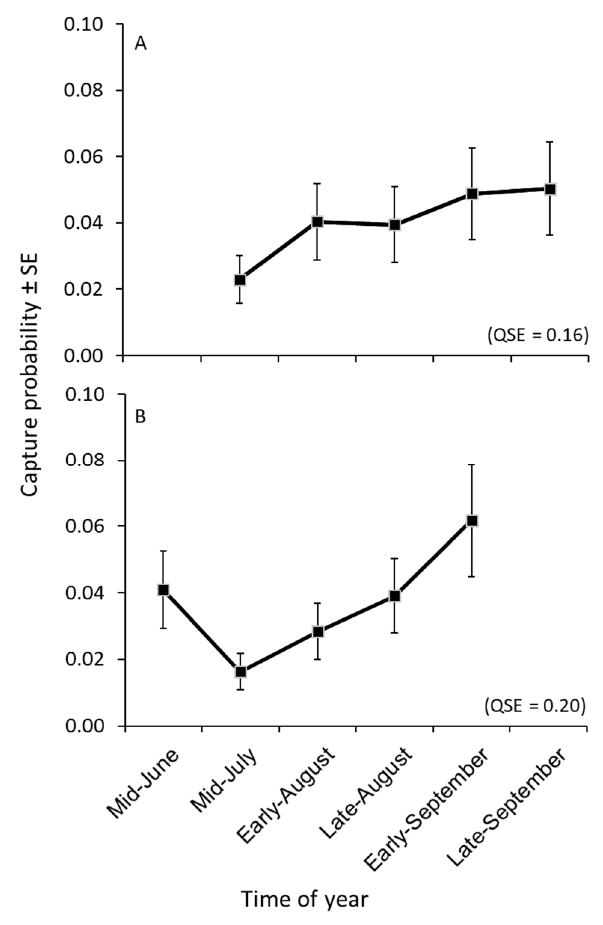
Figure 1. Capture ( p ) probabilities (±SE) for 2011 ( A ) and 2012 ( B ) translocated adult and released laboratory-propagated subadult Epioblasma capsaeformis by CMR sampling occasion at Cleveland Islands, Upper Clinch River, Russel County, Virginia estimated using closed-capture models in Program MARK. Raw estimates of quadrat sampling efficiency (QSE) on the substrate surface in late September are shown for comparison.